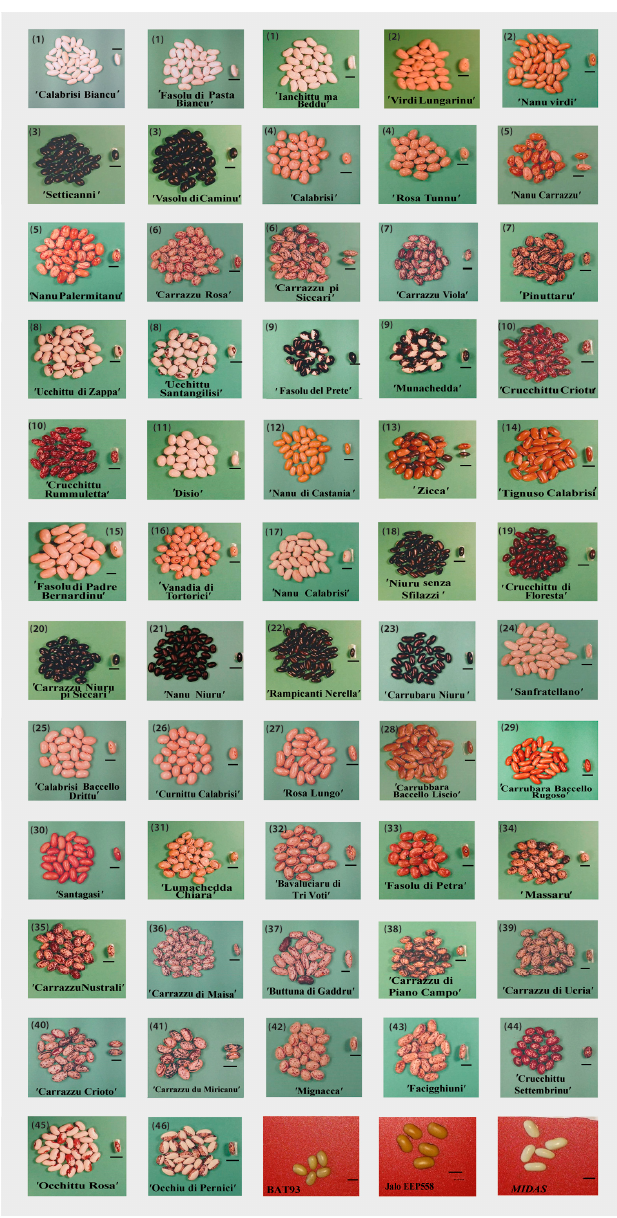
Figure 3. Fifteen-seven Sicilian common bean landraces conserved at SPGR/PA and “Living Plants Germplasm Bank” at Ucria sorted by seed morphotypes reported in Figure S2. Number in brackets = group morphotype. Three standard common bean genotypes are included (red background). Bar = 1